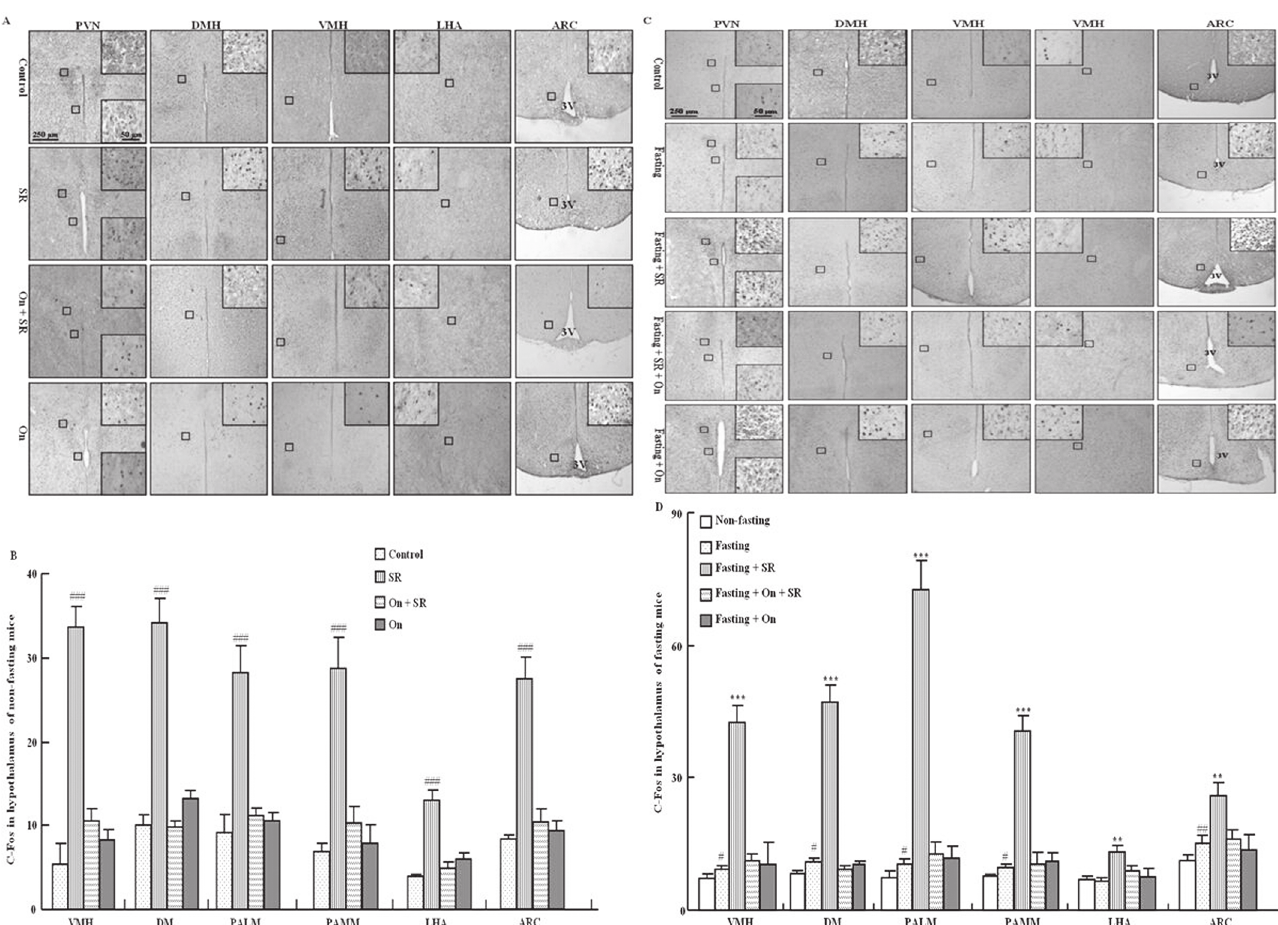
Fig 3. c-Fos expression in hypothalamus of fed and fasted mice. Typical photomicrographs of c-Fos expression in hypothalamus of fed mice (A) and fasted mice (C); Mean number of c-Fos-positive cells in hypothalamus of fed mice (B) and fasted mice (D). SR: SR 57227 (10 mg/kg, i.p.); On: ondansetron (3 mg/kg, i.p.). PVN: paraventricular nucleus of hypothalamus; DMH: dorsomedial hypothalamus; VMH: ventromedial hypothalamus; LHA: lateral hypothalamic area; PALM: paraventricular hypothalamic nucleus, lateral magnocellular part; PAMM: Paraventricular hypothalamic nucleus, medial magnocellular part; ARC: arcuate nuclei of the hypothalamus; 3V: third ventricle.Values are means ± SEM (n = 7 – 8). #, P < 0.05; ##, P < 0.01; ###, P < 0.001 vs. non-fasting control group; ** P < 0.01; *** , P < 0.001 vs. fasting control group.